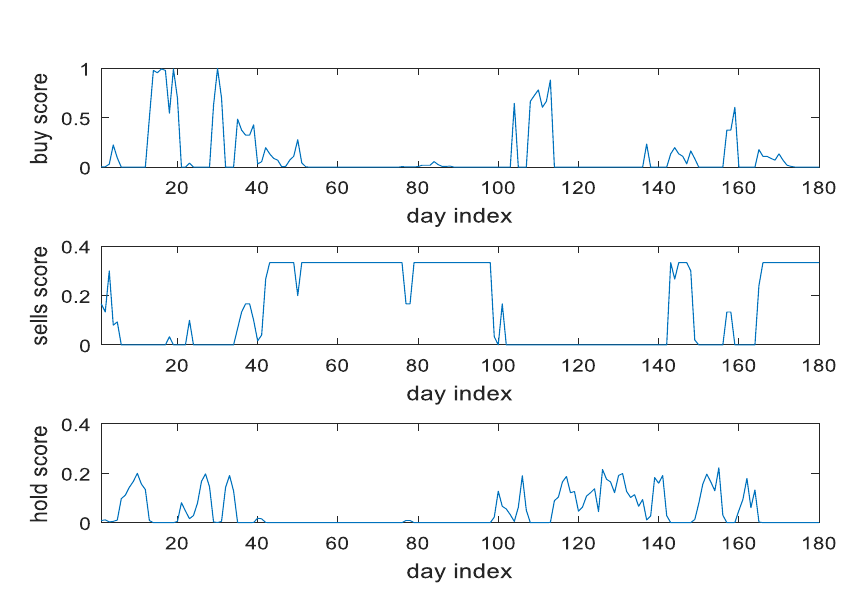
Figure 3. Signals strength for buying, holding and selling